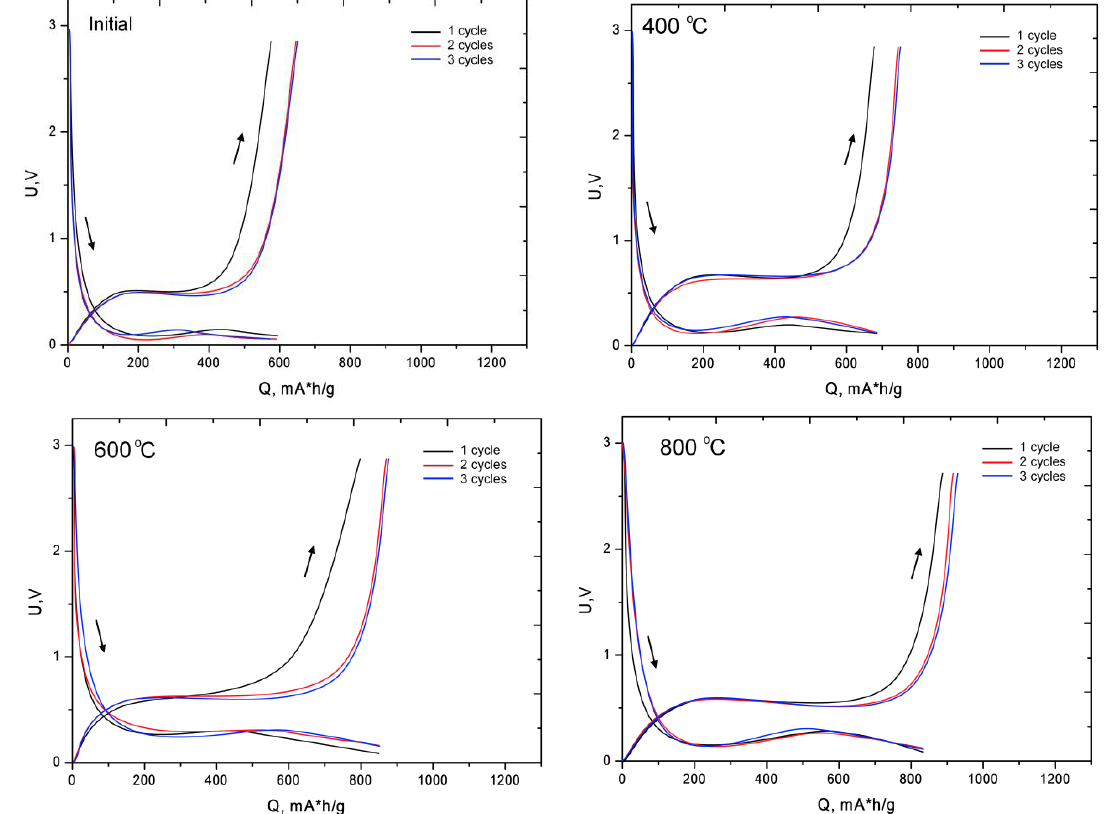
Figure 11. Charge-discharge curves of the first 3 cycles. The descending arrows demonstrate the charge (introduction of lithium into the anode), ascending demonstrate discharge (lithium extraction).